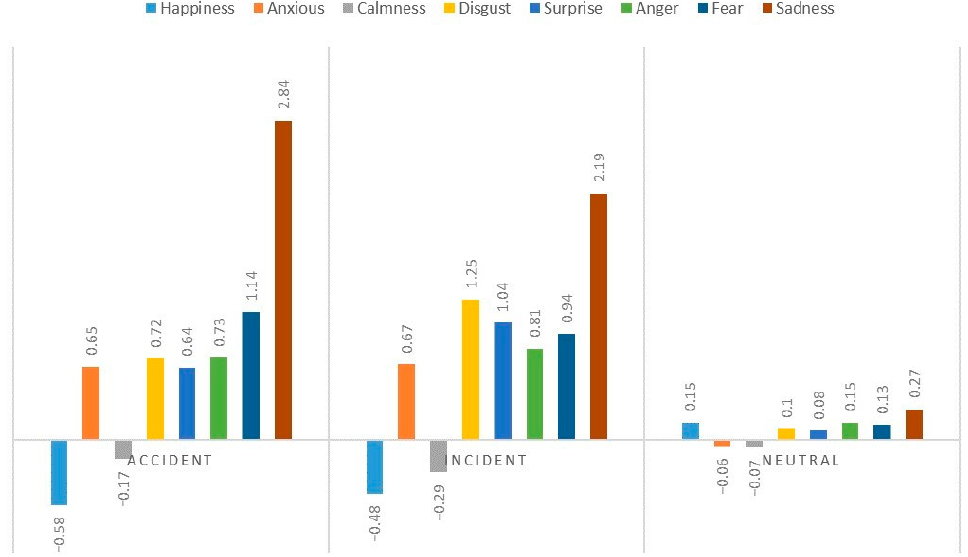
Figure 5. Pilot’s emotional state of various dimensions under different induction condi- tions.